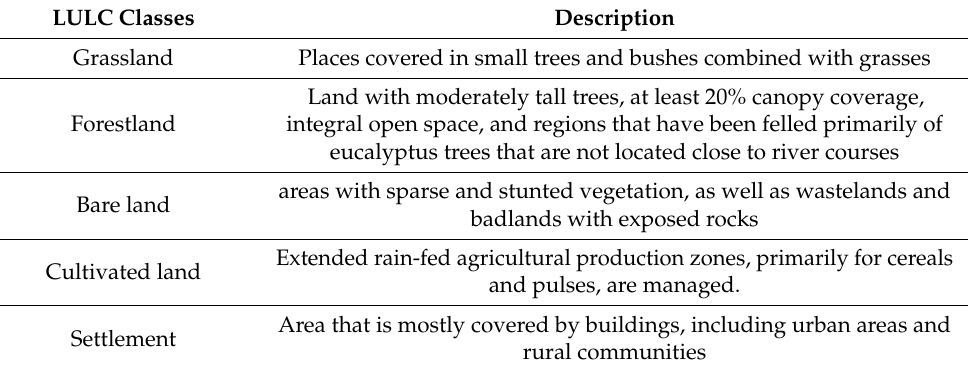
Table 2. LULC classified description in the Matenchose watershed. LULC Classes